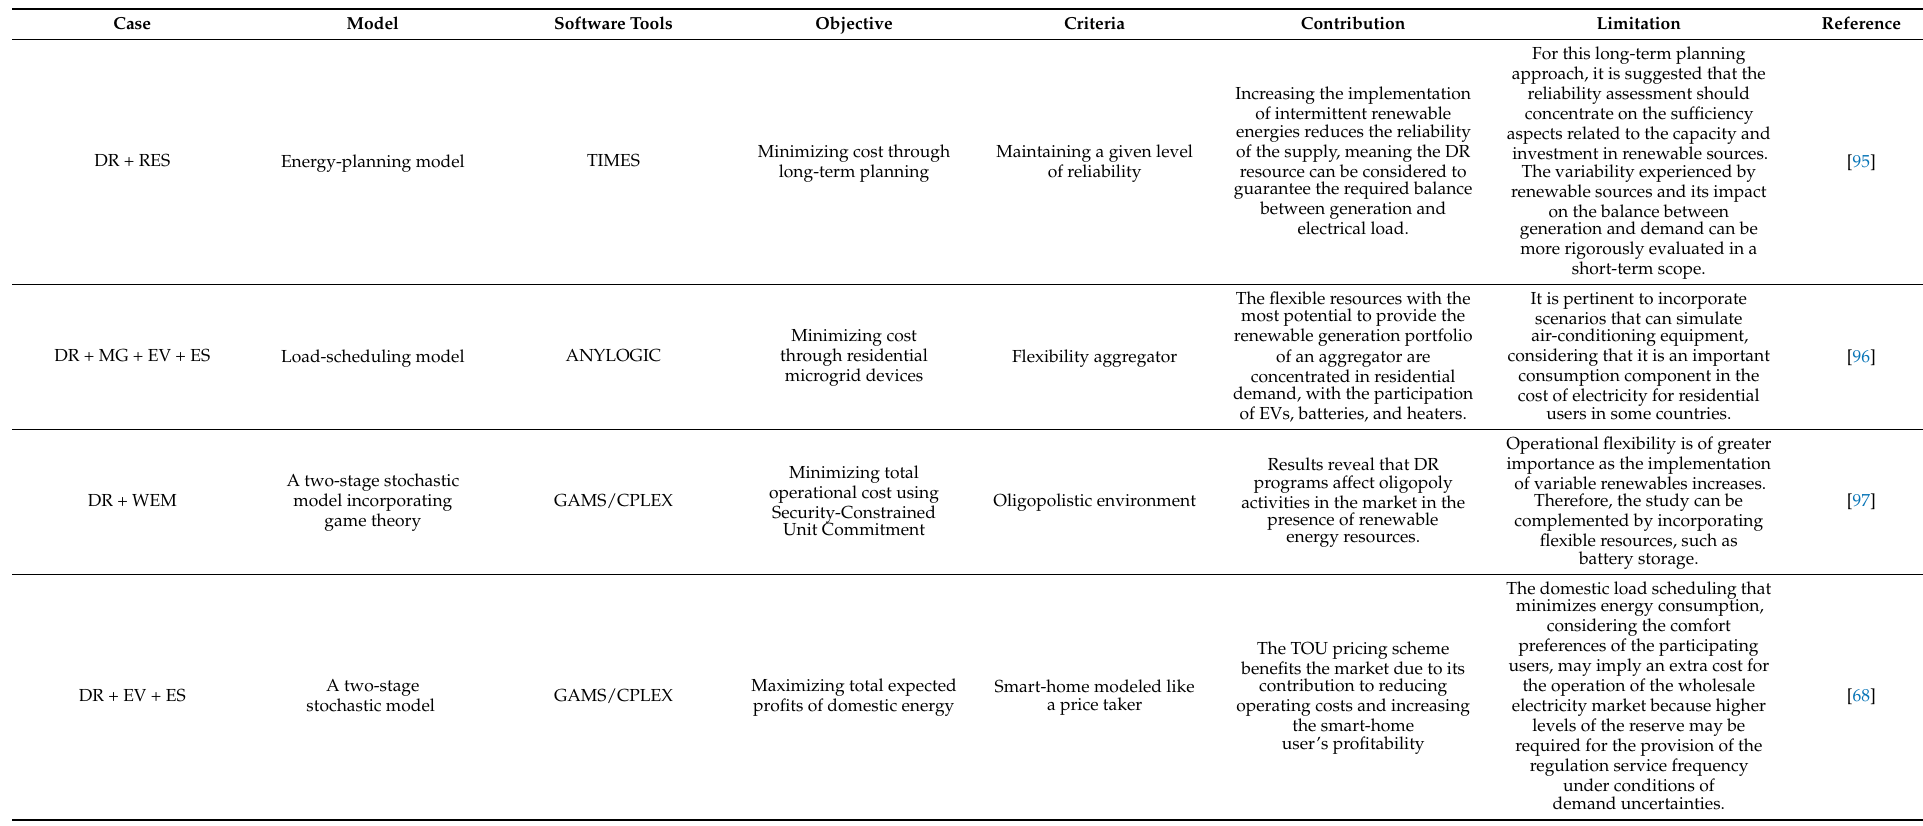
Table 1. Characterization of methodologies for modeling demand